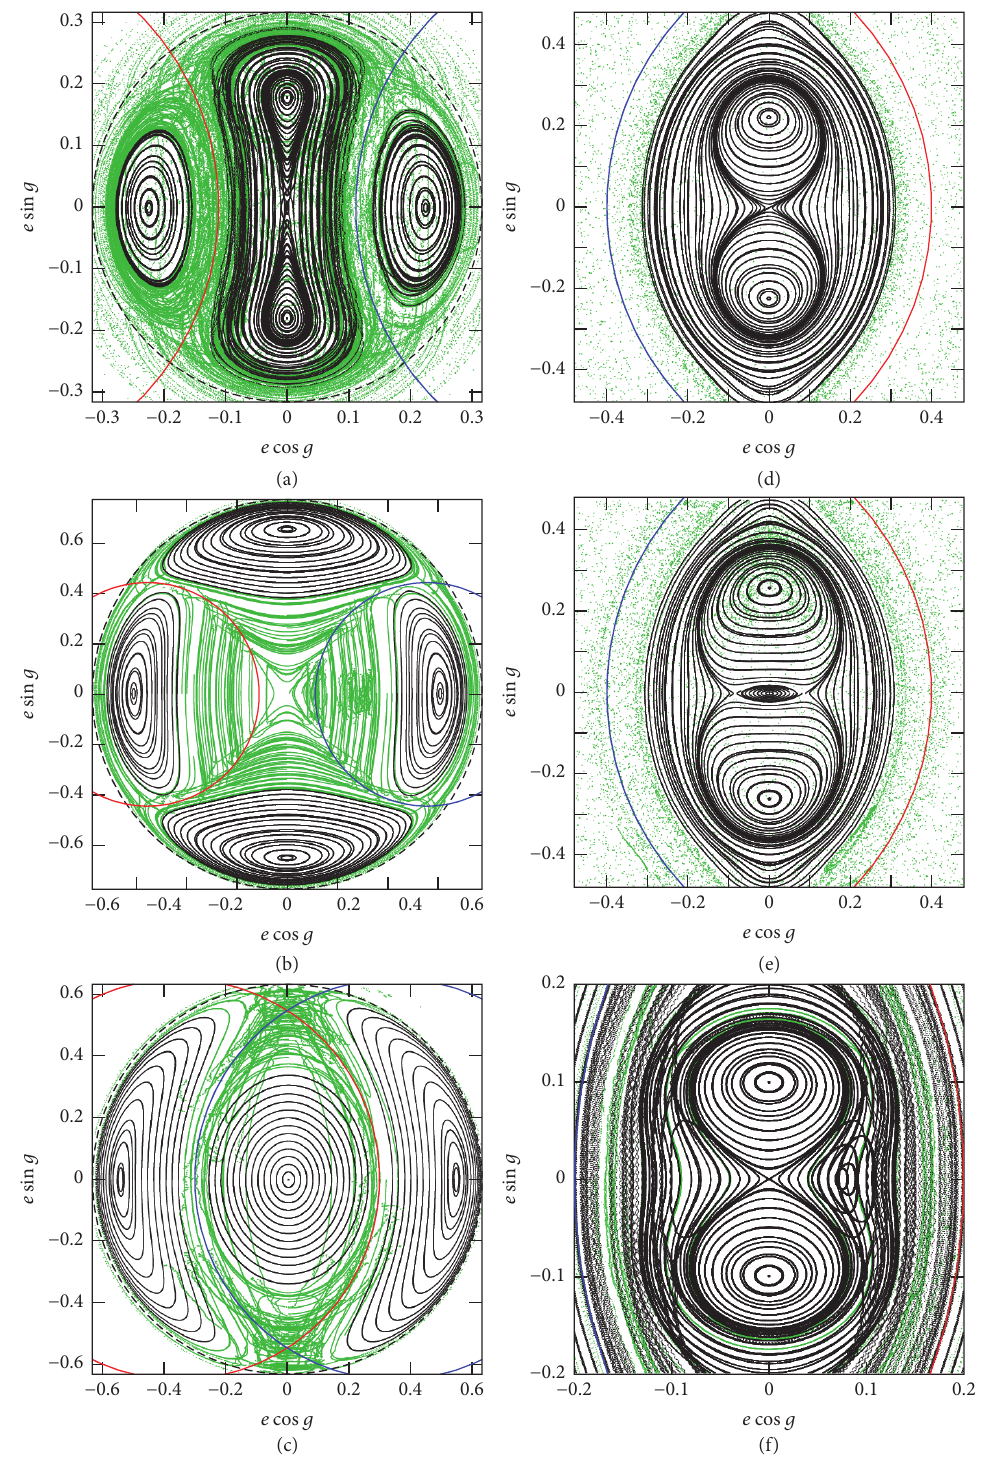
Figure 3: Plots of the perturbed body’s (𝑒 cos 𝑔,𝑒 sin 𝑔) values obtained from the direct numerical integration whose parameters are listed in Table 1. As for the meaning of the black dashed circles and of the red and blue partial circles, see the caption of Figure 2. The green dots represent the trajectories of bodies that experienced orbital instability during the integration period. Stable trajectories are drawn by black